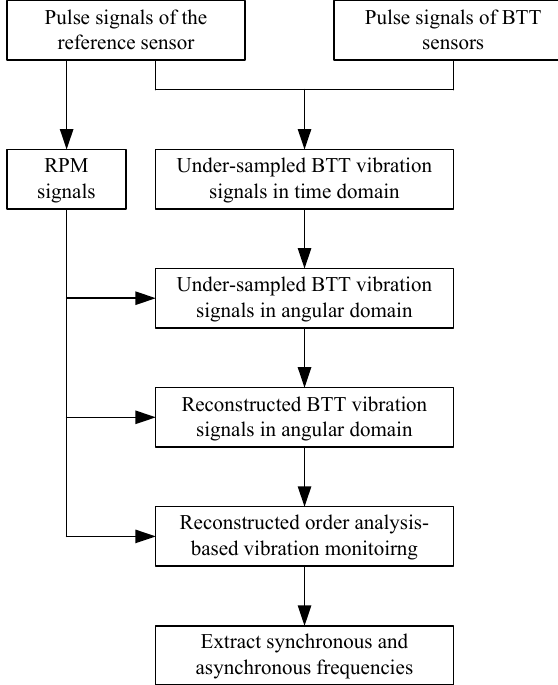
Figure 2. The structure of reconstructed order analysis-based BTT vibration monitoring.